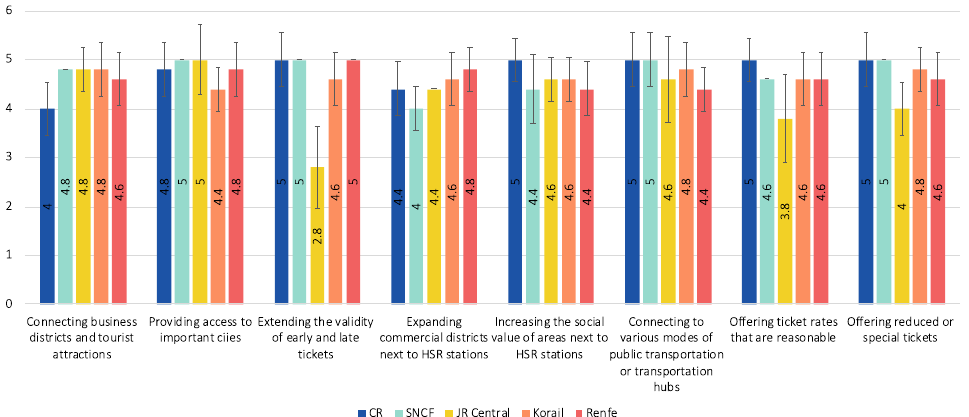
Figure 10. A summary of railway experts’ responses to questions on policy implications by